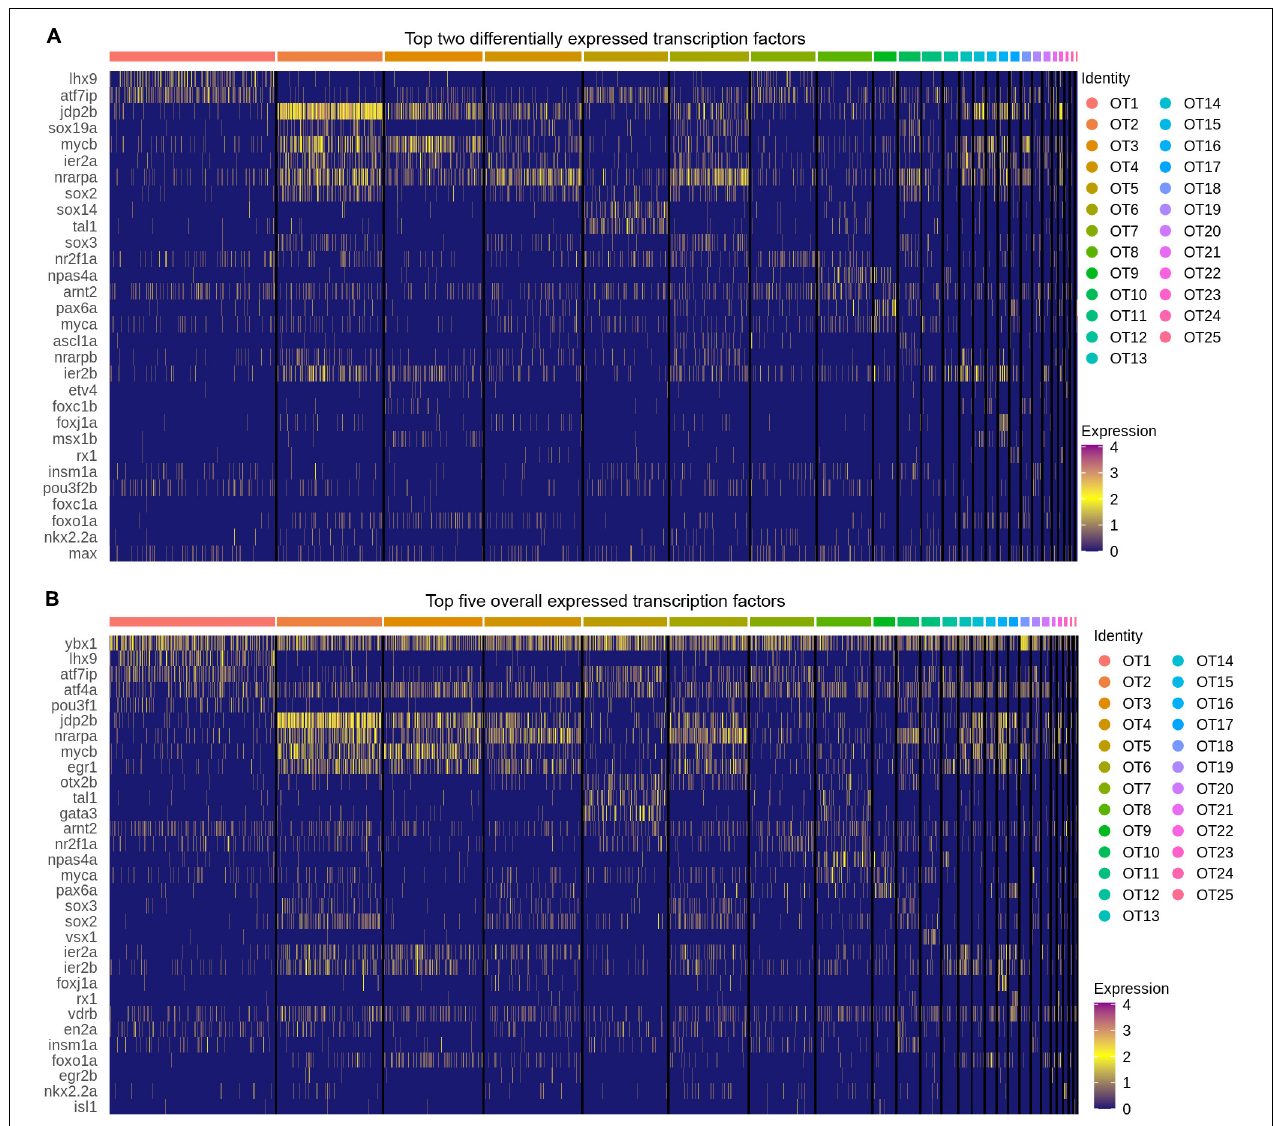
FIGURE 5 | Top transcription factors in the larval zebrafish OT. (A) The top two differentially expressed transcription factors in each OT population as compared to all other cells. (B) Top five expressed transcription factors in each population. (All) Duplicates of top factors are allowed but displayed only once. Factors were considered differentially expressed for a particular cluster if they were expressed > 0.25 log2 fold change above all other cells and are present > 25% of cells within the cluster. Factors were ordered in decreasing expression (log2fc) level and the top two or five were selected for visualization; see Supplementary Table 8 for all transcription